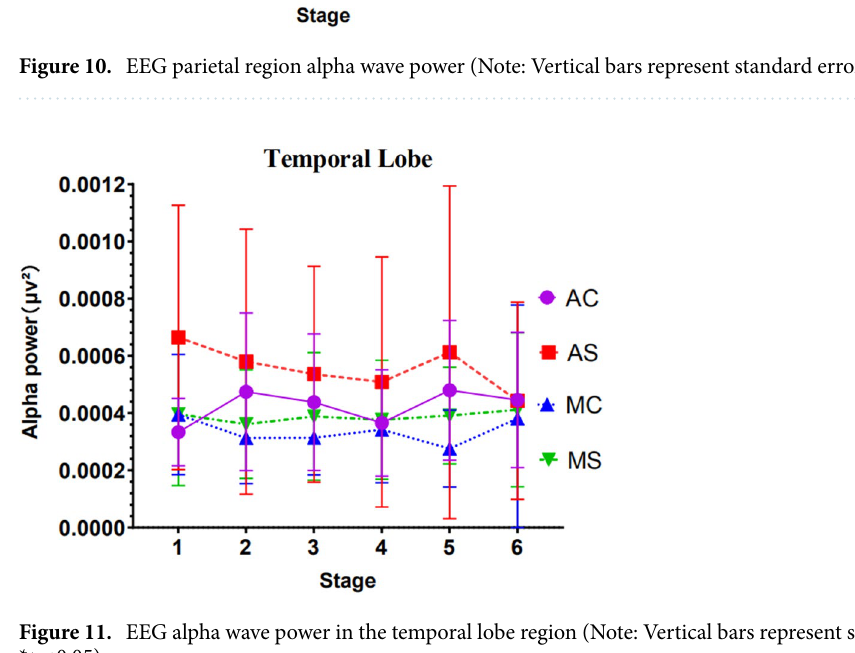
Figure 11. EEG alpha wave power in the temporal lobe region (Note: Vertical bars represent standard errors, * p <